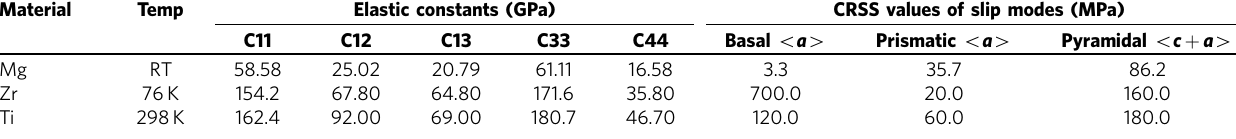
Table 1 | Elastic and plastic parameters of hcp Mg, Zr and Ti. Material